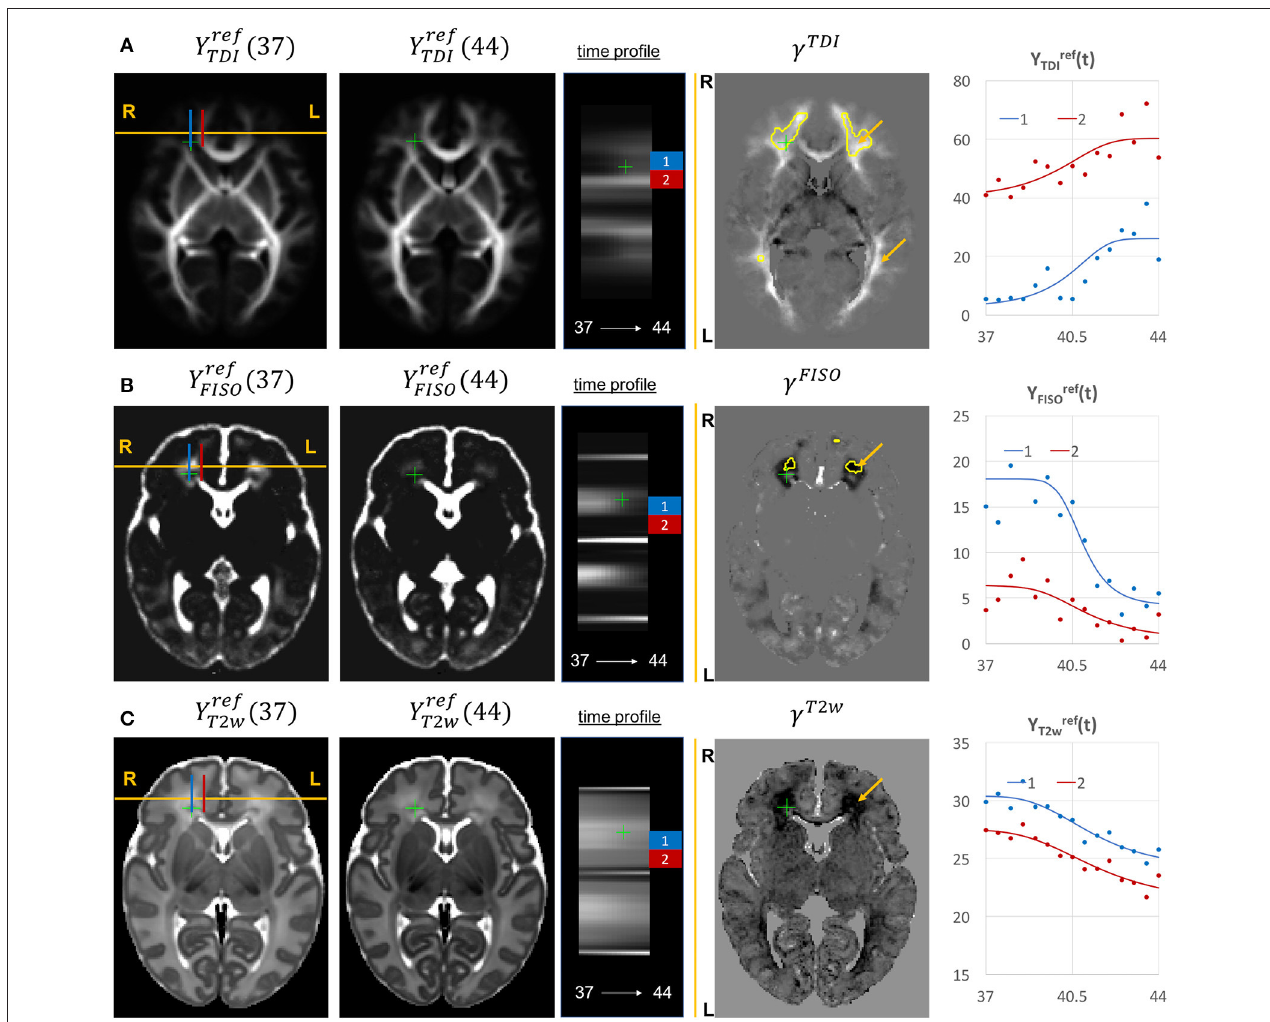
FIGURE 12 | Examples of the signal changes in time (in the reference space) in TDI (A) , FISO (B) , and T2w (C) channels. First column: 37 week template. Second column: 44 week template. Third column: signal change in time. Fourth column: γ c maps. Fifth column: Signal change in time in age-specific templates Y (2) c , t and fitted Gompertz function Y ref c ( t ) computed over 3 × 3 × 3 voxel regions in two locations: prefrontal corpus callosum (red) and Von Monakow WM segment (blue). The regions highlighted with yellow contours have > 0.2 weeks growth peak offset in τ c